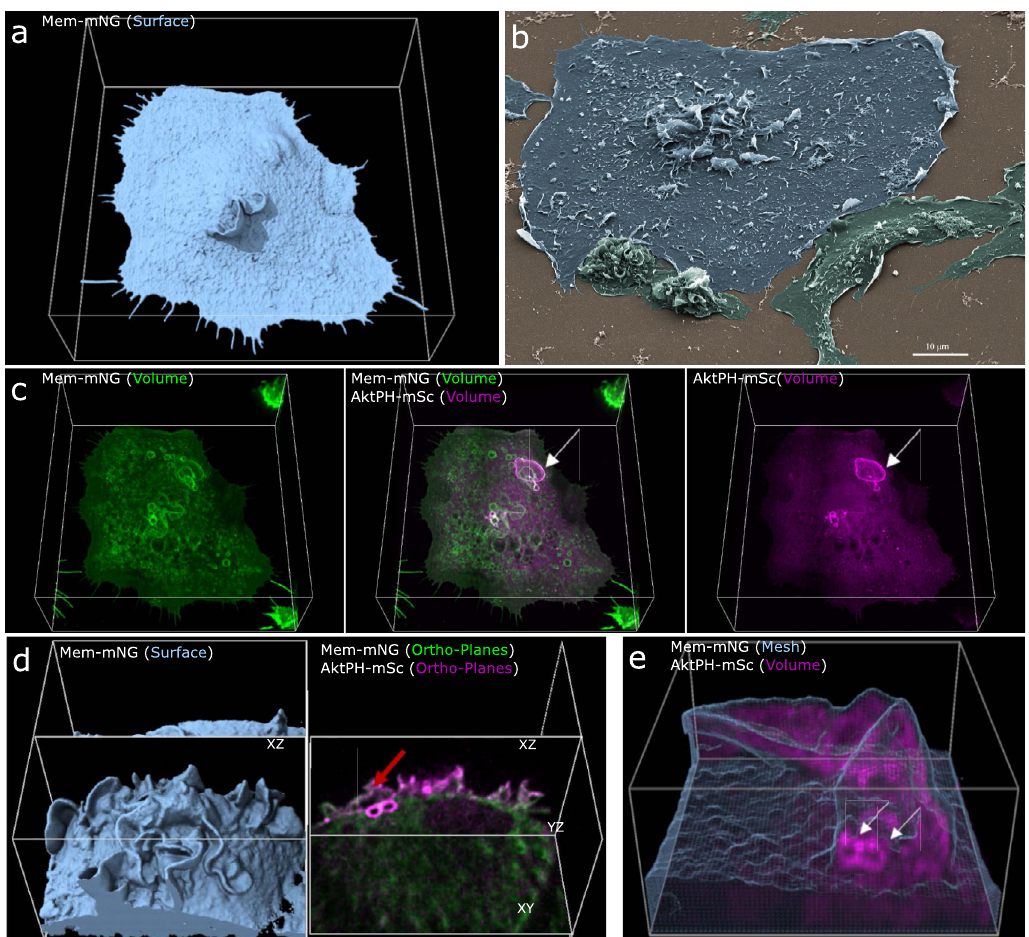
Fig. 1 3D visualization of macrophages allows insight into membrane structure and phosphatidylinositol dynamics during macropinocytosis. a Isosurfaces show the plasma membrane of a live cell that is actively macropinocytosing (region 68 × 72 × 25 µ m x , y , z ). b SEM image of a macrophage acutely stimulated with CSF-1 shows representative high-resolution fi xed cells ( n = 10 micrographs, scale bar is 10 µ m). c Volumetric intensities show speci fi c local fl uorescence (left → right) volumetric membrane (green), dual volumetric membrane and AktPH-mSc, volumetric AktPH-mSc (magenta). Volumetric renderings provide a method to visualize the transient fl uorescent intensities throughout the volume of the cell (region 68 × 72 × 25 µ m). d Combinations of visualization techniques such as isosurface (left) displayed alongside orthogonal planes (right) further clarify how each plane is chosen to show internal intensities (region 29 × 30 × 19 µ m). e Mesh rendering of the Mem-mNG probe along with volumetric AktPH-mSc provides a representation of the plasma membrane structure as well as underlying fl uorescence. The white arrows indicate the post closure recruitment of AktPH-mSc (region 13